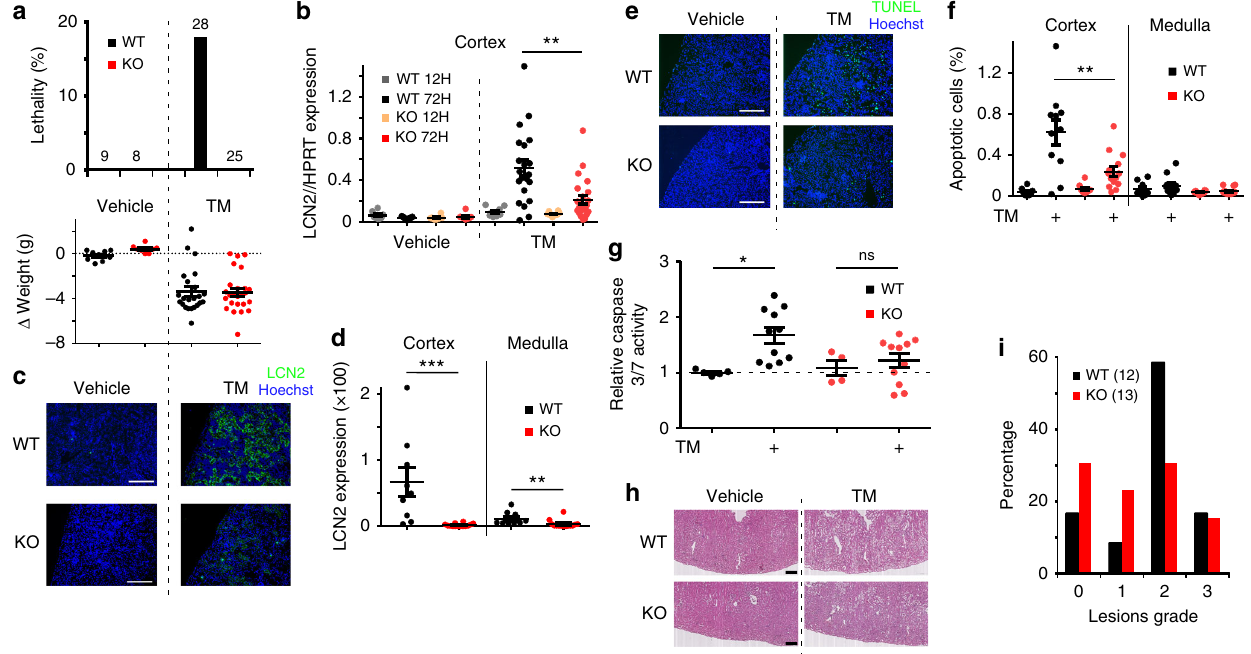
Fig. 7 Deletion of TMEM33 in the mouse confers protection against AKI. a Percentage of lethality (the number of mice is indicated) is shown in the top panel. The bottom panel shows the amount of weight loss induced by TM injection. WT: black bars and dots; KO: red bars and dots. b Expression of LCN2, as detected by qPCR in mouse renal cortex 12or 72 h after TM (2 mg/kg) injection, comparing WT (gray and black dots) and KO (orange and red dots) mice. c LCN2 and Hoechst staining on cortical sections of kidney from WT and KO mice injected with vehicle or TM (same n values as a). Scale bars indicate 200 μ m. d Relative intensity (TM/vehicle) of LCN2 staining in the cortex and medulla of WT and KO mice. e Tunel and Hoechst staining on cortical sections from kidneys of mice injected with vehicle or TM, comparing WT and KO mice. Scale bars indicate 200 μ m. f Percentage of apoptotic cells in the cortex and the medulla. g Relative (to the vehicle treated WT mice) caspase 3/7 activity determined in renal cortical homogenates from WT and KO mice either injected with vehicle or TM. h Hematoxylin staining of cortical renal sections of WT and KO mice injected with vehicle or TM. i Quanti fi cation of lesion grades on cortical sections from WT and KO mice injected with vehicle or TM. The number of mice is indicated on the graph. Values are means ± SEM overlaid with dot plots. One star indicates p < 0.05, two stars p < 0.01 and three stars p < 0.001, with a one-way permutation test used to evaluate statistical signi fi cance. Source data are provided as a Source Data fi